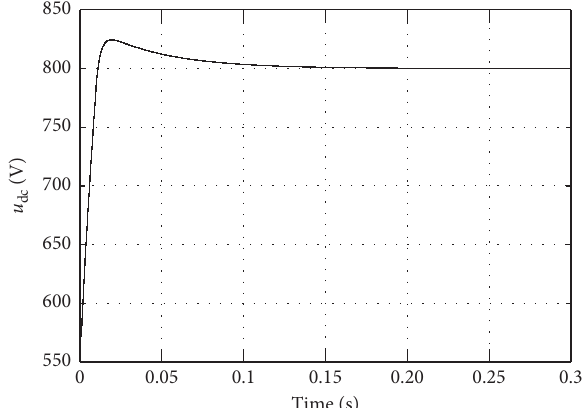
Figure 12: The DC bus voltage waveform of AC/DC converter without